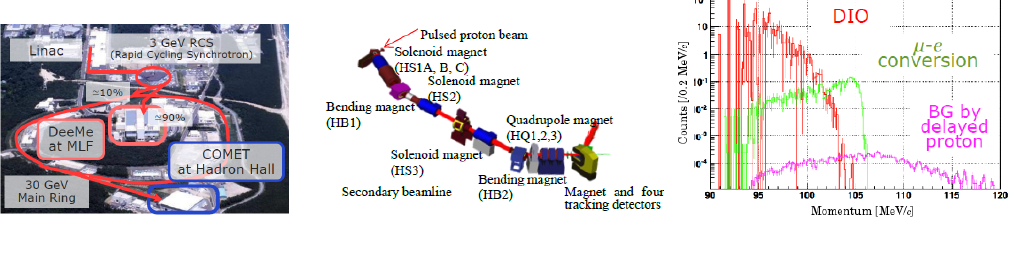
Figure 2: The experimental apparatus of the DeeMe ex- periment at J-PARC MLF H- Line.